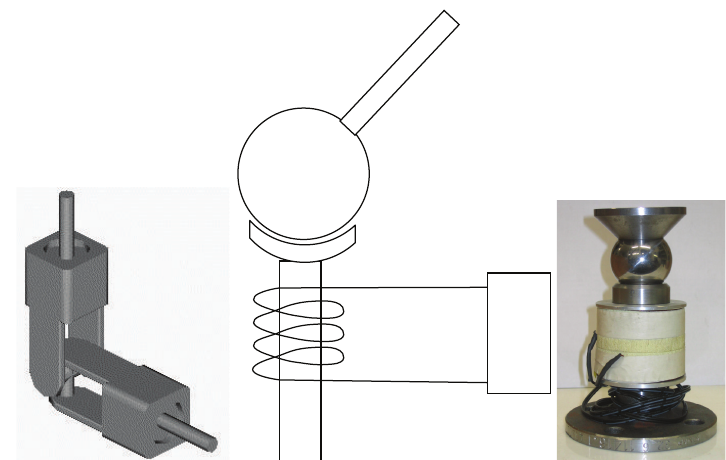
Figure 7: Two variants of spherical joint with significantly increased movability.